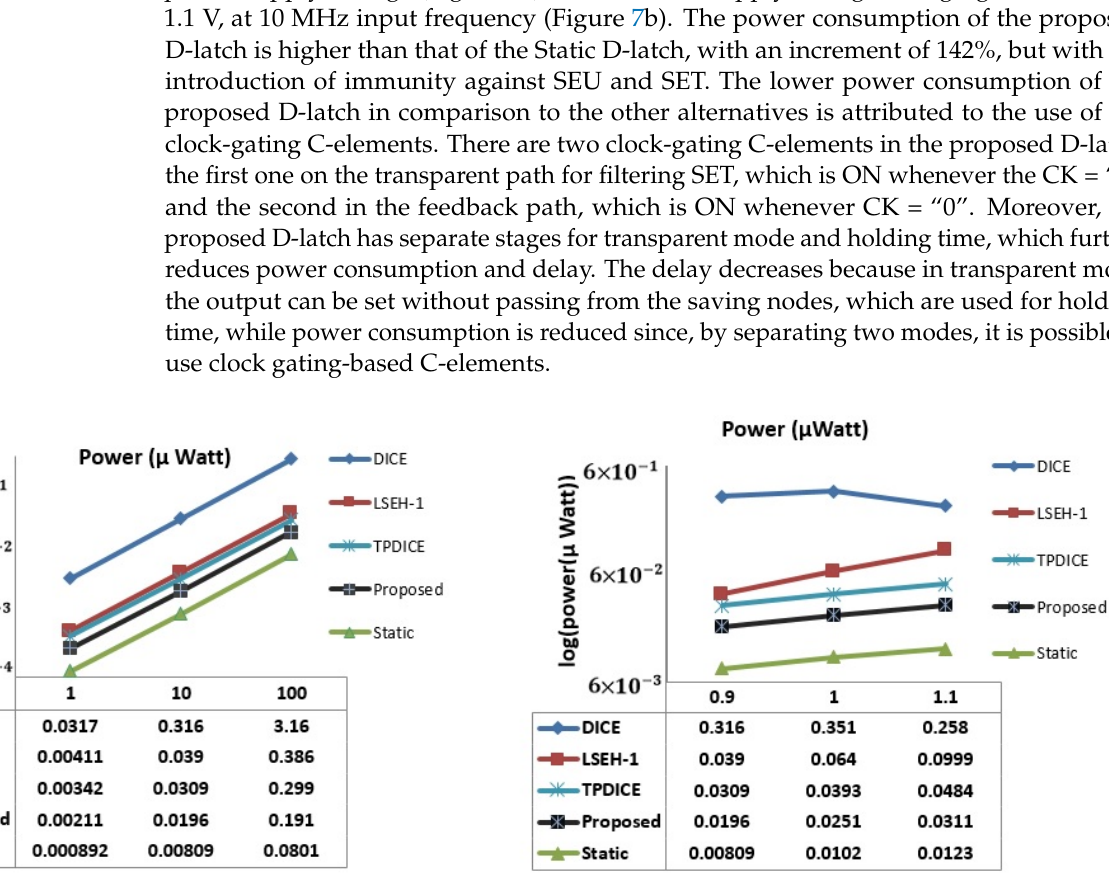
( b ) Figure 8. Delay of various D-latches: ( a ) at various frequencies from 1 MHz to 100 MHz and 0.9 V power supply voltage; ( b ) at three supply voltages and 10 MHz input frequency. 4.3. PDP Furthermore, as PDP is a figure of merit showing the total performance of D-latches and, in particular, commonly used to evaluate hardened D-latches [7,30], a PDP compar- ison of the proposed and previous D-latches is shown in Figure 9. As can be seen, the PDP of the proposed D-latch is even slightly better than that of the Static D-latch, with a 3.67%